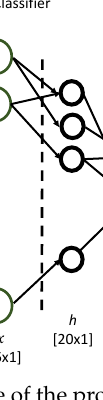
Figure 7. Architecture of the proposed autoencoder MLP 1 classifier.